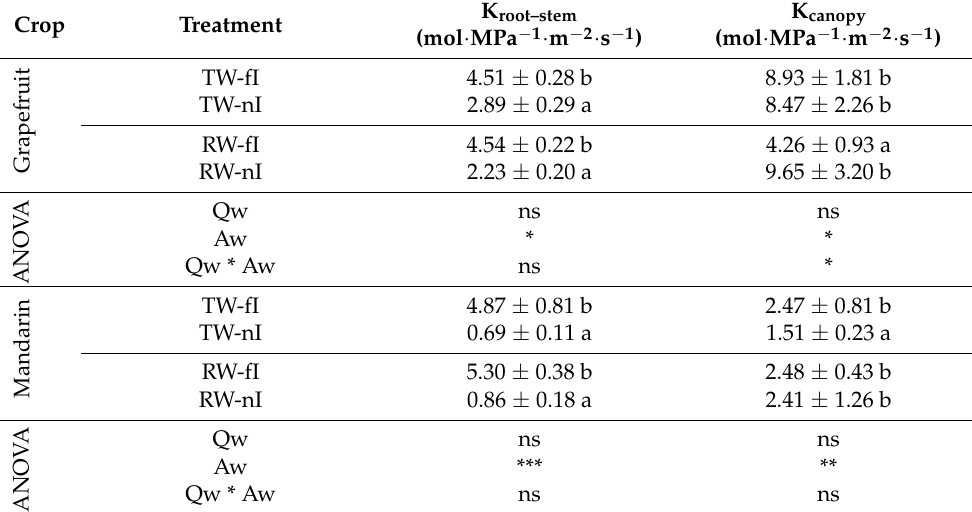
Table 2. Root–stem hydraulic conductance (K root–stem ) and canopy hydraulic conductance (K canopy ) values for each treatment and crop (grapefruit and mandarin). Each value is the average ± standard deviation of 4 blocks, collected at 248 DOY. Within each column, different letters indicate significant differences at p < 0.05, as assessed using Tukey’s test. In two-way ANOVA, including water quality (Qw) and amount (Aw) as factors, *** p < 0.001, ** p < 0.01, * p < 0.05; ns: not